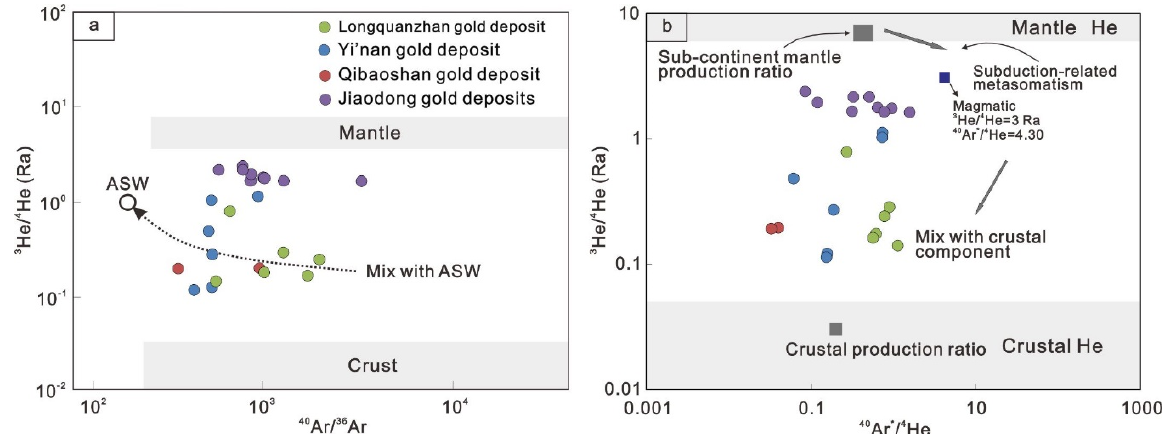
Figure 9. ( a ) R/Ra vs. 40 Ar/ 36 Ar and ( b ) R/Ra vs. 40 Ar*/ 4 He plots of inclusion-trapped fluids in pyrite from the Longquan- zhan gold deposit and the Luxi-Jiaodong gold ore system. The He–Ar isotopic data for the typical Jiaodong gold deposits are from [44] and [45]. The magmatic and crustal end-member 3 He/ 4 He ratios of the Jiaodong area are from [12] and [46], respectively. ASW = atmospheric saturated water (after [47]).